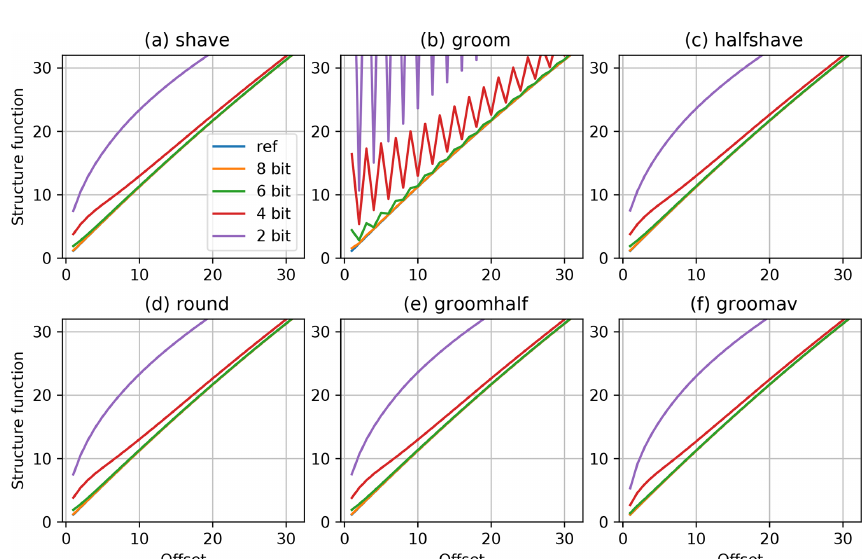
Figure 3. The structure functions (Eq. 3) of the correlated signal shown in Fig. 2a, processed with different precision trimmings.